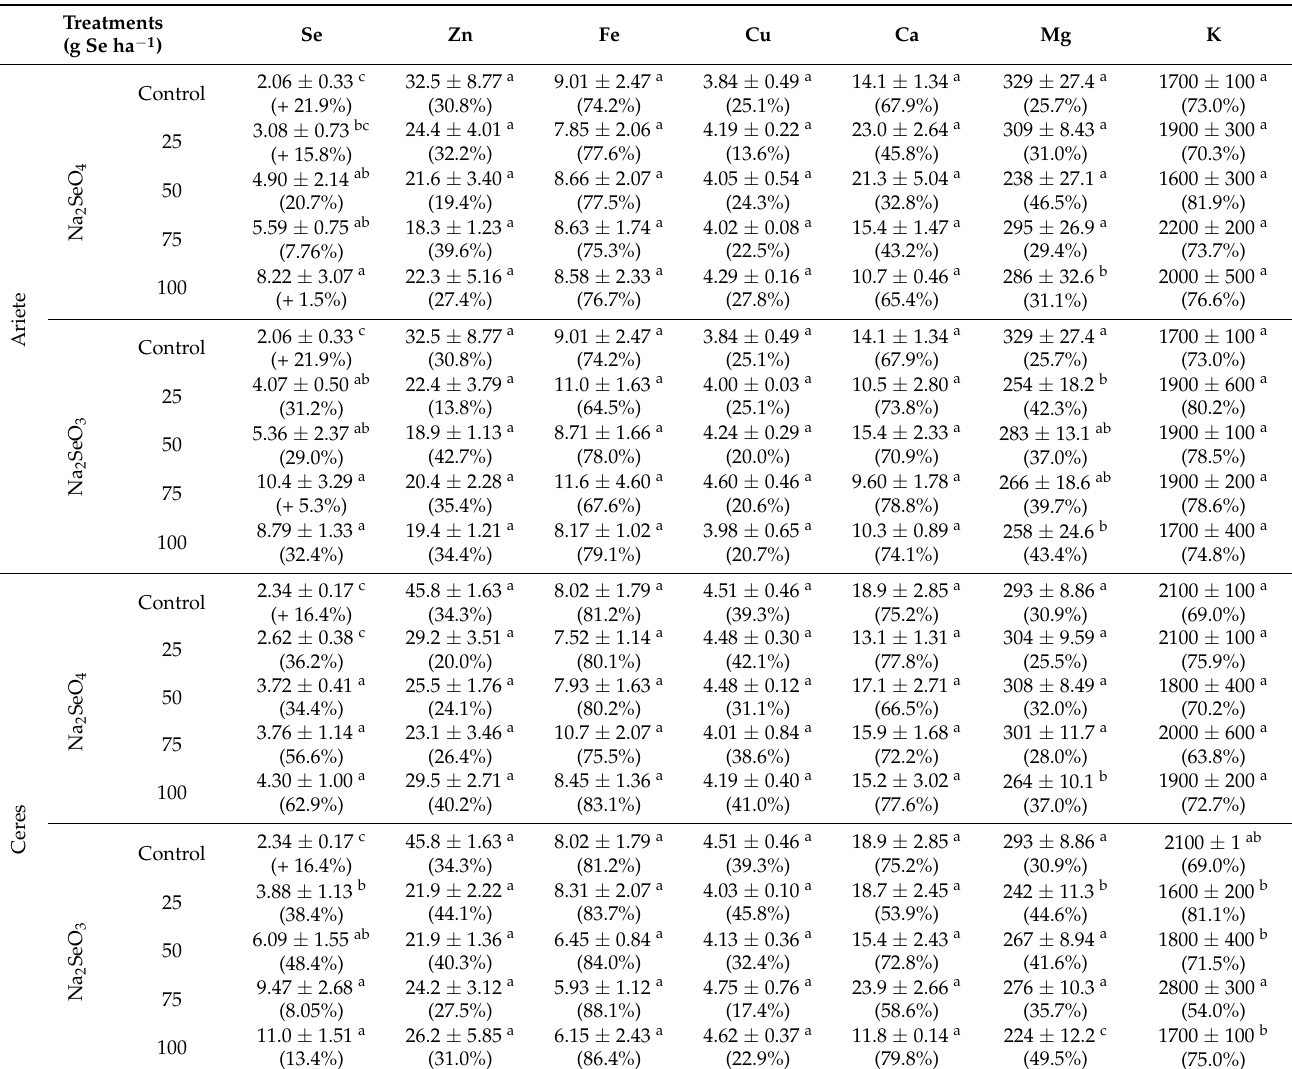
Table 3. Selenium, zinc, iron, copper, calcium, magnesium and potassium concentrations in the white grains of O. sativa cultivars. Treatments (g Se ha − 1